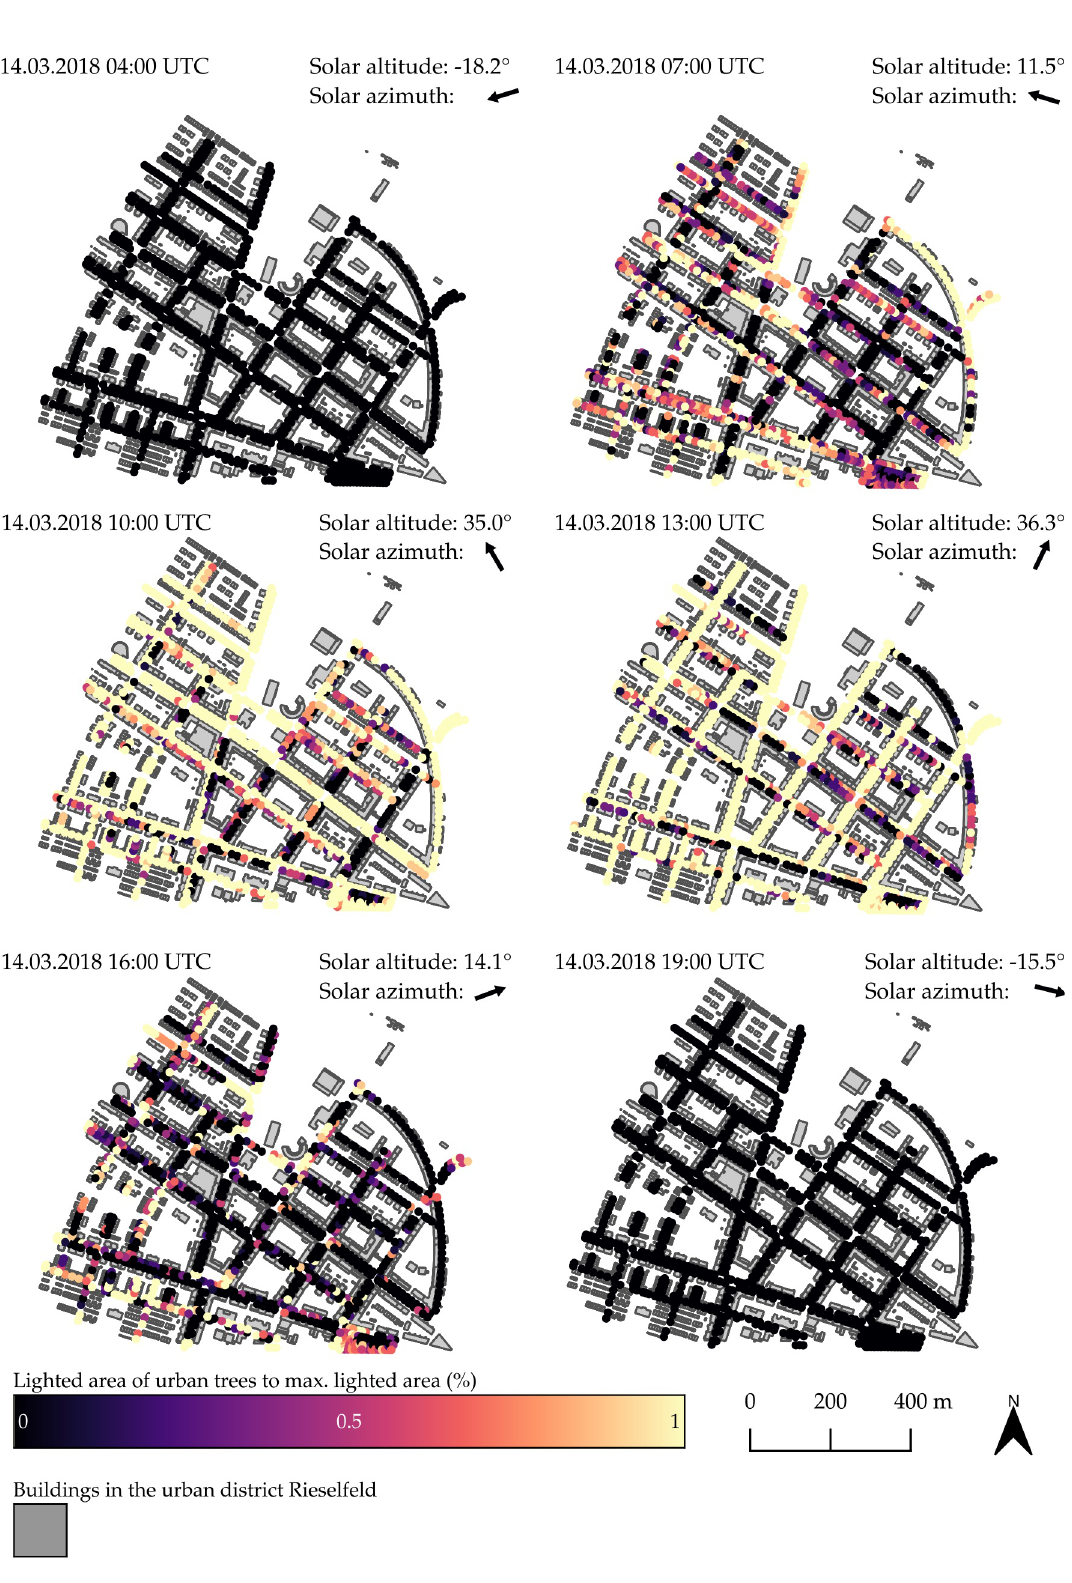
Figure 9. Ratio between sunlit area and max. sunlit area of urban trees for the 14th of March under clear-sky conditions. It is observable that the lighting of the study area starts according to the solar azimuth angle at the east side and ends at the west side of the district. It is also conspicuous, that the lighting of the trees is dependent on the orientation of the streets and buildings for small solar altitude angles, but less dependent for greater solar altitude